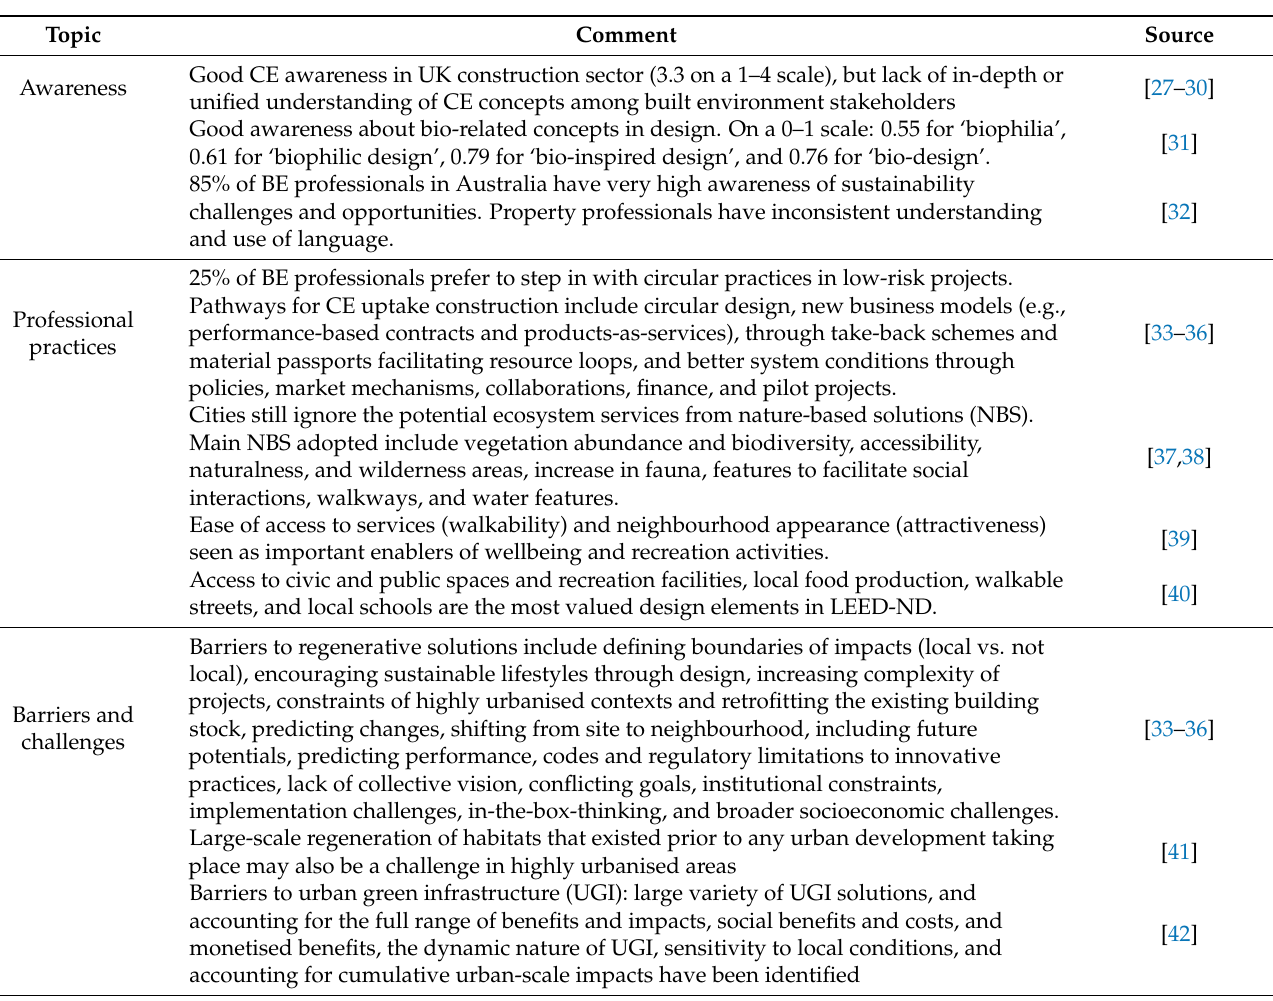
Table 1. Summary of aspects relevant to a regenerative and circular transition of the existing bu- ilt